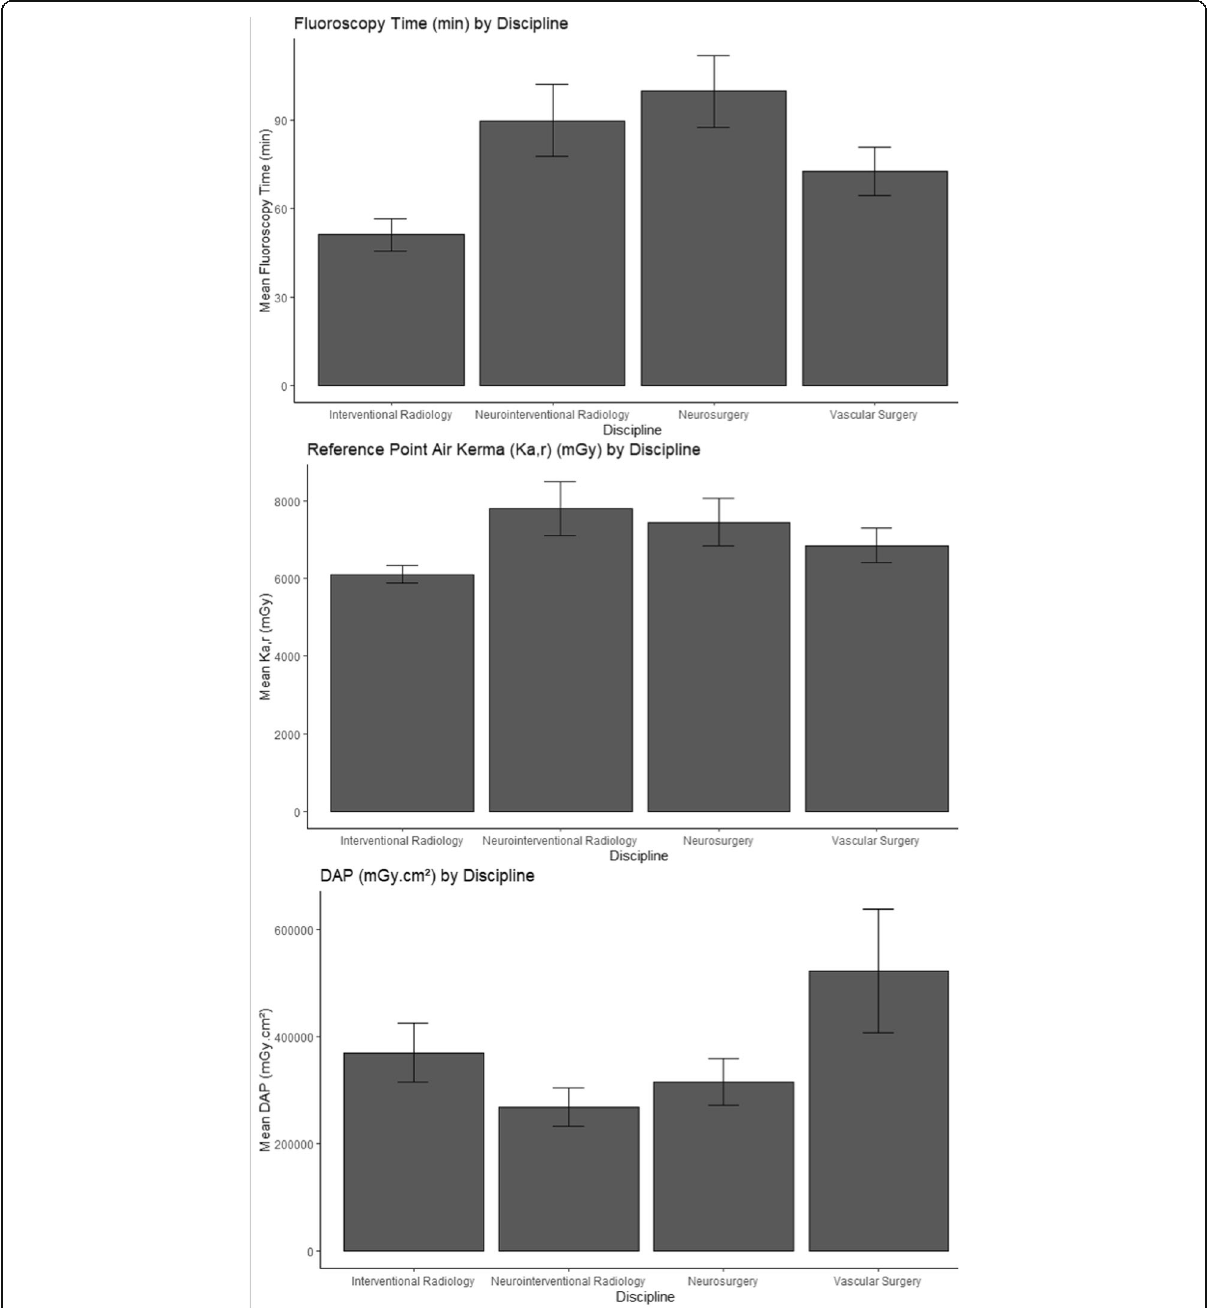
Fig. 2 Mean FT, DAP, and K a,r , and standard deviation by medical discipline (FT = fluoroscopy time, DAP = dose area product, K a,r. = reference point air